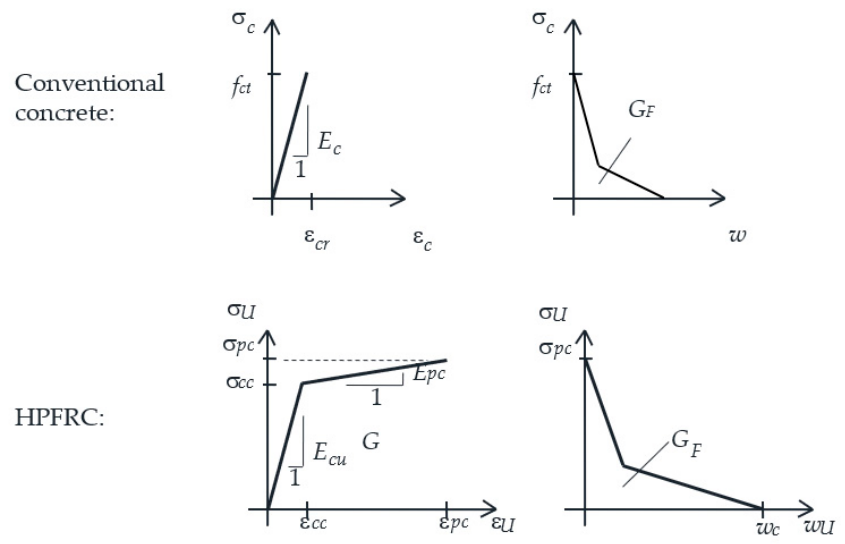
Figure 2. Tension behavior of conventional concrete and HPFRC, abstracted from [14–17].